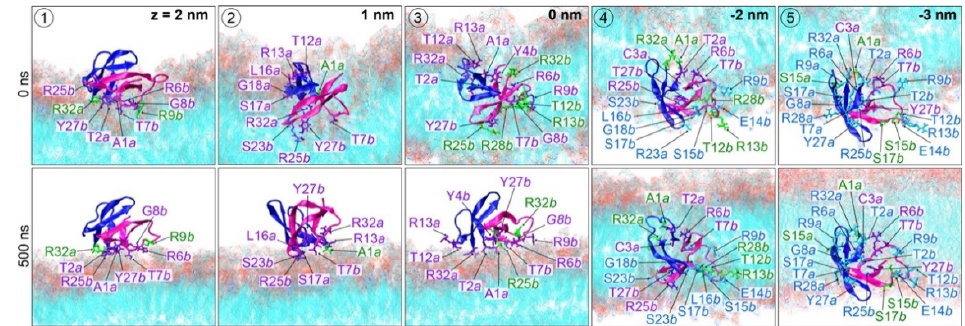
Figure 7. Orientation of dimeric HD5 molecules. Key residues that form hydrogen bonds in Figure 6 are labeled. Residues that interact with KDO, Pi of lipid A (Pi(outer)), and Pi of phospholipid head groups (Pi(inner)) are colored in violet, green, and cyan, respectively. The lowercase “ a ” and “ b ” letters indicate the chain of HD5.